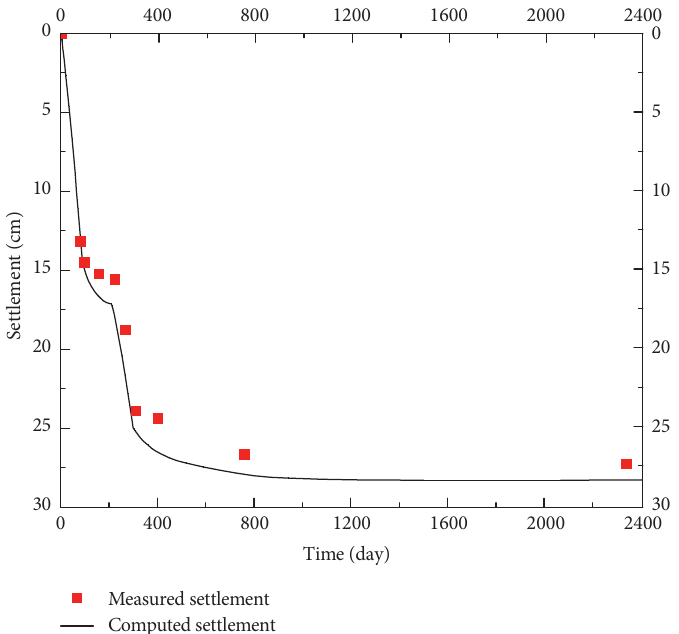
Figure 3: Measured and computed settlement at the base of the embankment.